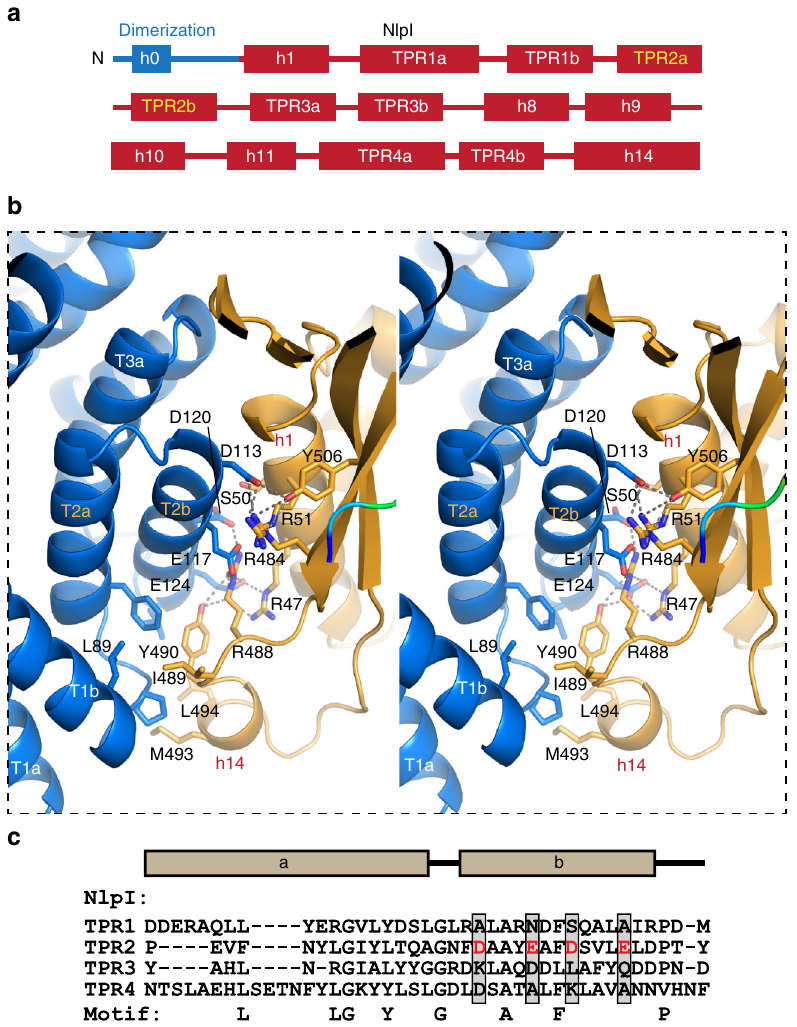
Fig. 3 The binding interface between NlpI and Prc. a Domain organization of NlpI. The two TPR helices interacting with Prc are labeled in orange color. b Zoomed-in stereo view showing the interacting residues of NlpI (blue) and Prc (gold) in sticks. T2a/b and T3a indicate the TPR2a/b and TPR3a helices, respectively. c Sequence alignment of NlpI ’ s TPRs highlighting the acidic residues in